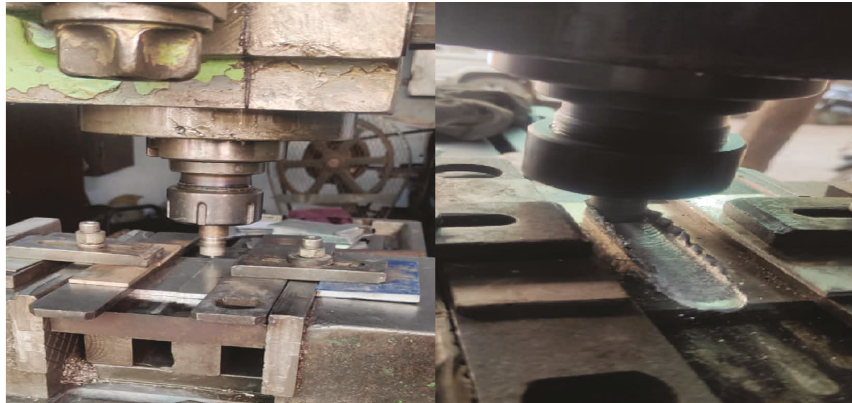
Figure 2: Tool and plate arrangements during the FSW process.